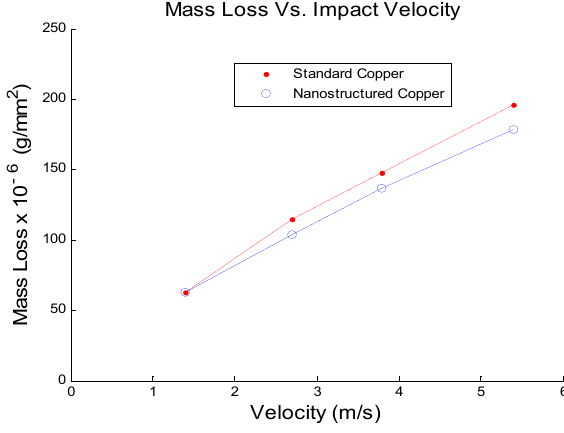
Figure 4. Mass loss versus velocity for both standard and nanostructure copper.